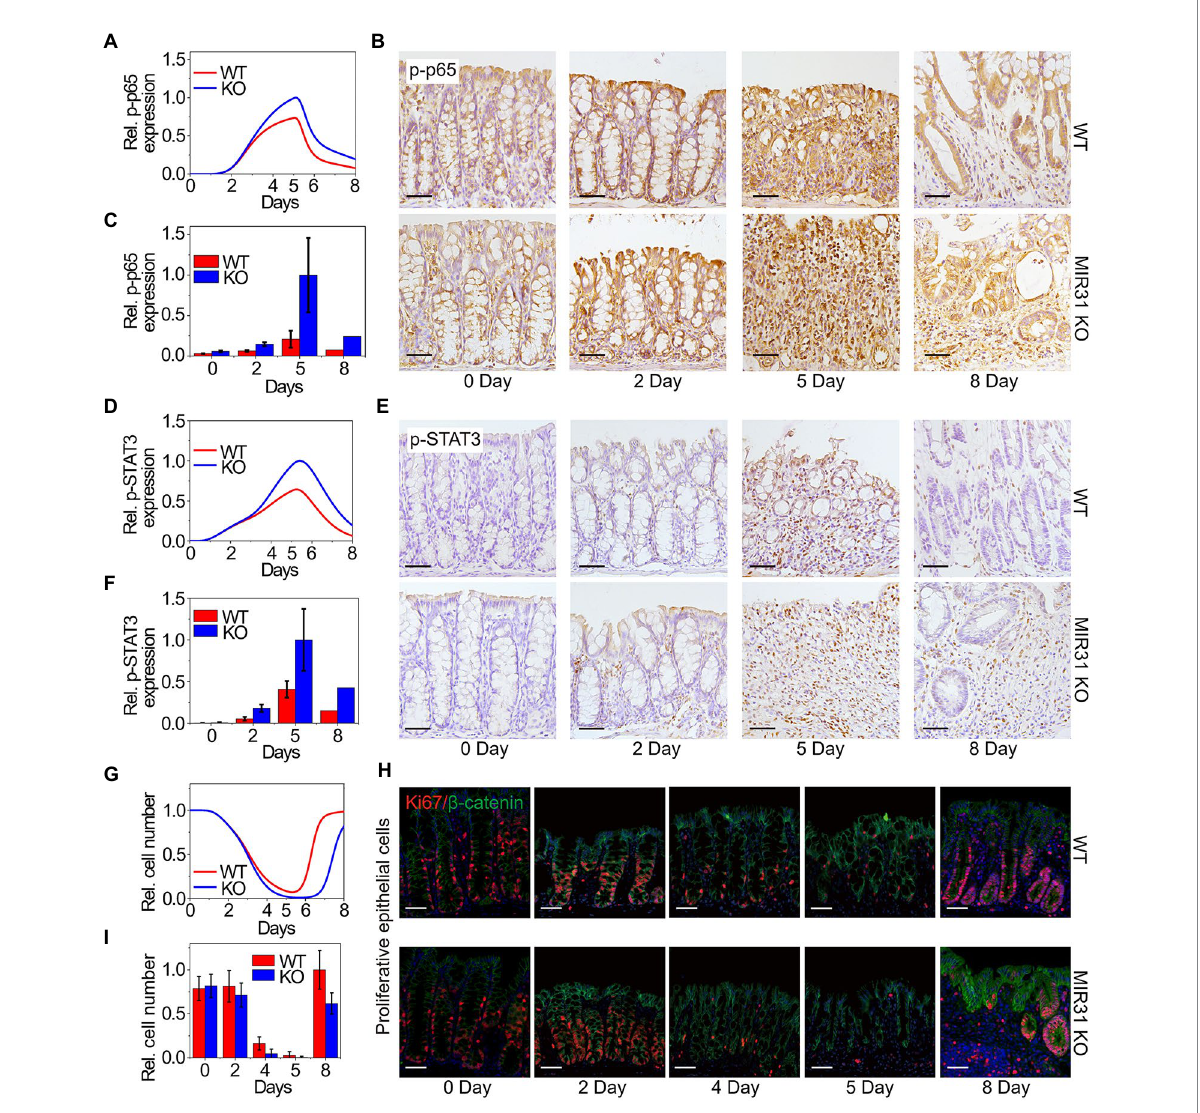
FIGURE 4 Modeling predictions and experimental confirmations in WT and MIR31-KO mice. (A,D,G) Model predictions of p65 activation (A) , STAT3 activation (D) and the proliferative cell number (G) for the WT and MIR31-KO models over time after DSS treatment. (B,E,H) Immunofluorescence for p65 (B) , p-STAT3 (E) , and Ki67/ β -catenin (H) in colons from WT and MIR31-KO mice at the indicated time points following DSS treatment. n = 3 at each time point. (C,F,I) Corresponding statistical histograms of experimental results for p65 in panel (B) , for p-STAT3 in panel (E) , and for the proliferative cell number in panel (H) , respectively. All the results in (A,C,D,F,G,I) are normalized to the corresponding maximum